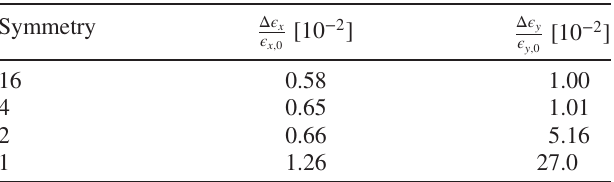
TABLE VII. Relative emittance growth for the 16-cell triplet lattices with different